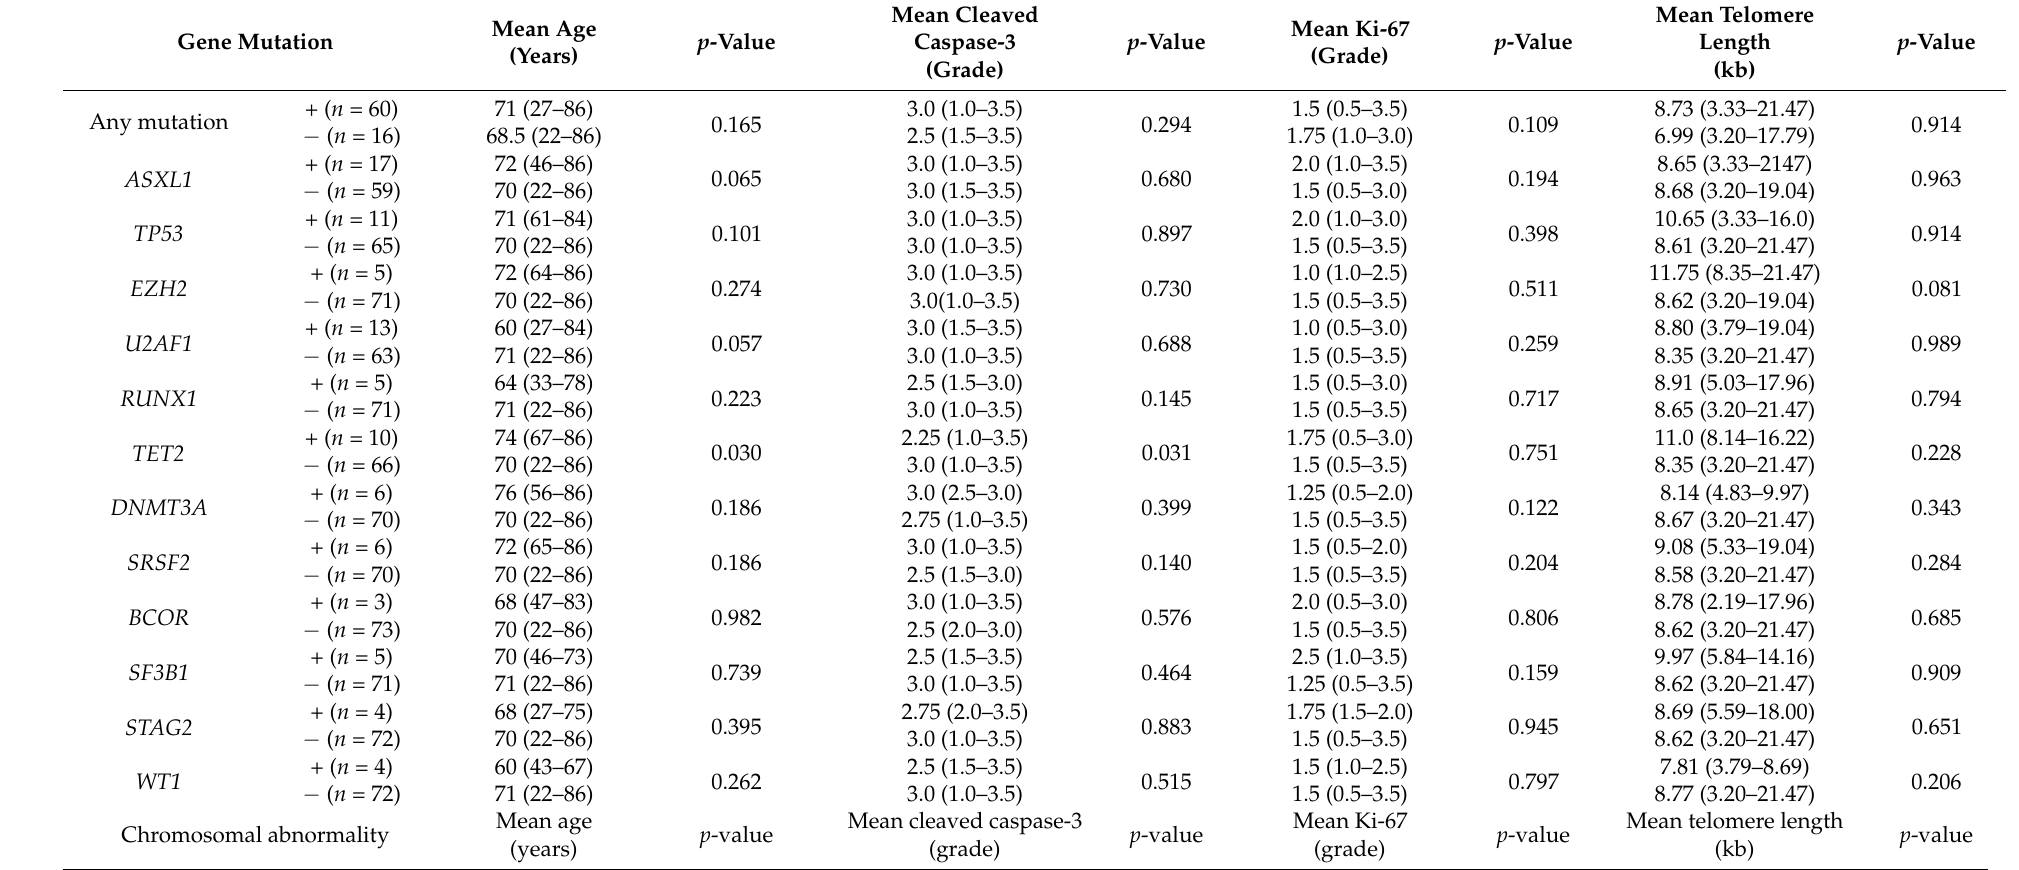
Table 2. Mutational